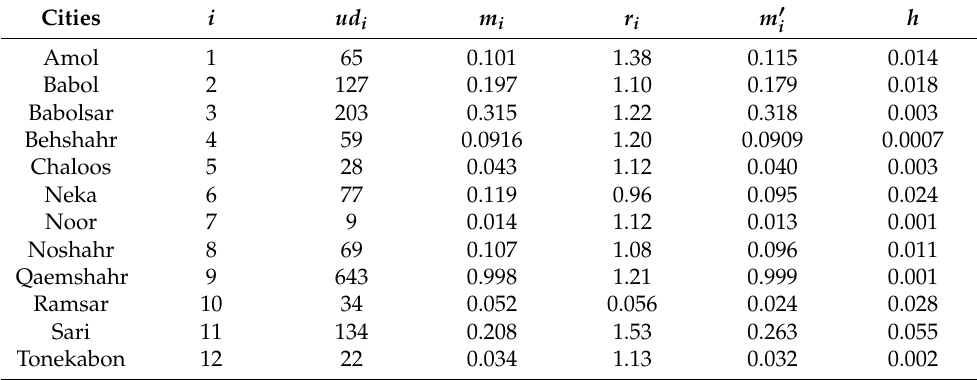
Table 5. Outlining